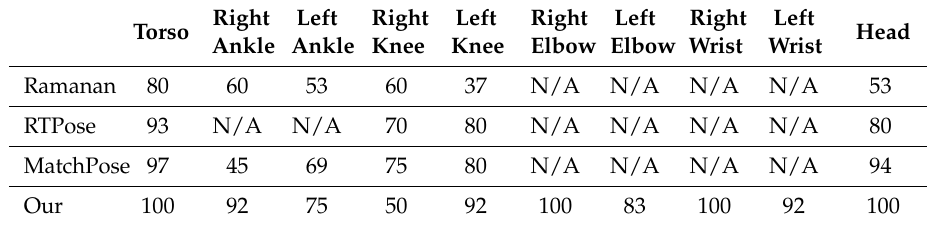
Table 4. Comparisons with previous results. The numbers represent accuracy in percentage. N/A means the data are not available from their